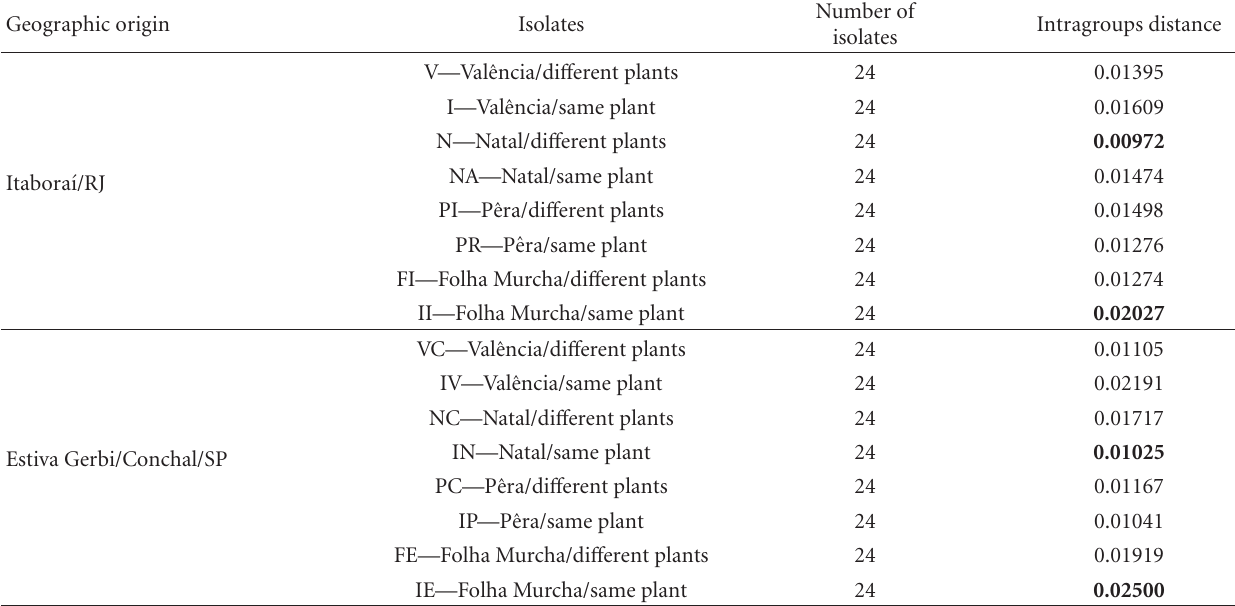
Table 1: Number of isolates by sampling and intragroups genetic distances showed by groups of isolates from symptomatic tissues from the four di ff erent orange varieties in two geographic